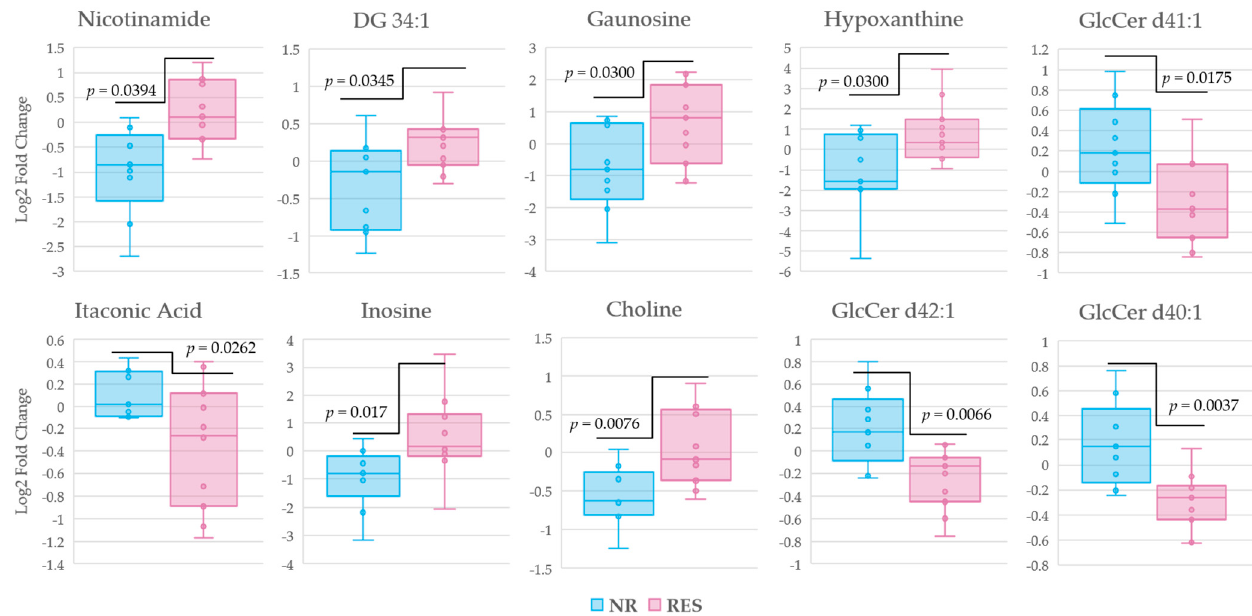
Figure 6. Box and whisker plots of changes in metabolite levels distinguishing non-responders and responders according to a δ DAS ( − 1.2), representing a lowering in disease activity score of 1.2. Then, metabolites were cross referenced according to DAS-28 < 2.6, the threshold recognized as remission in RA. The log normalized change in peak intensity for ten metabolites from baseline to sixteen weeks post MTX therapy identified by univariate analysis are displayed. Non-responders (blue); responders (pink); diglyceride (DG); glucosylceramide (GlcCer).